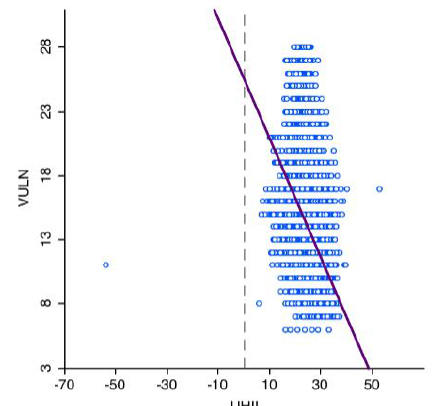
Figure 13. Scatterplot UHII versus vulnerability index for Phoenix. There is a negative UHII value because the hottest block in Maricopa County is not located inside the urban boundary.